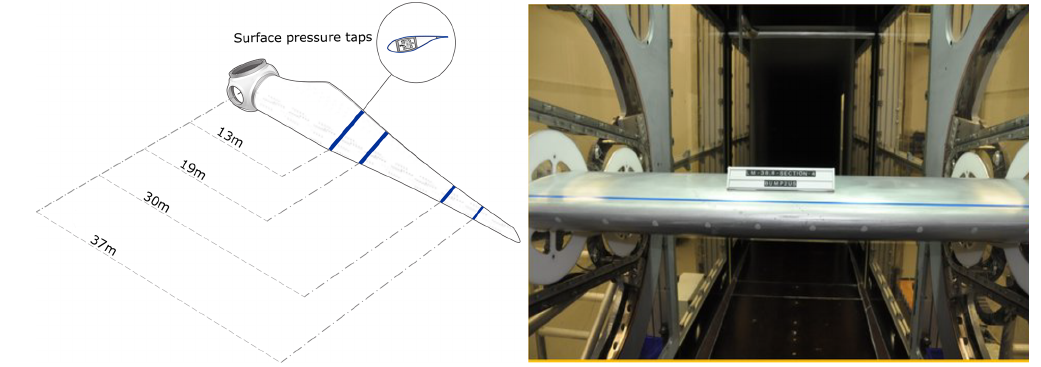
Figure 1. Schematic of NM80 wind turbine blade implemented with surface pressure taps (left) and NACA 63-418 airfoil blade section